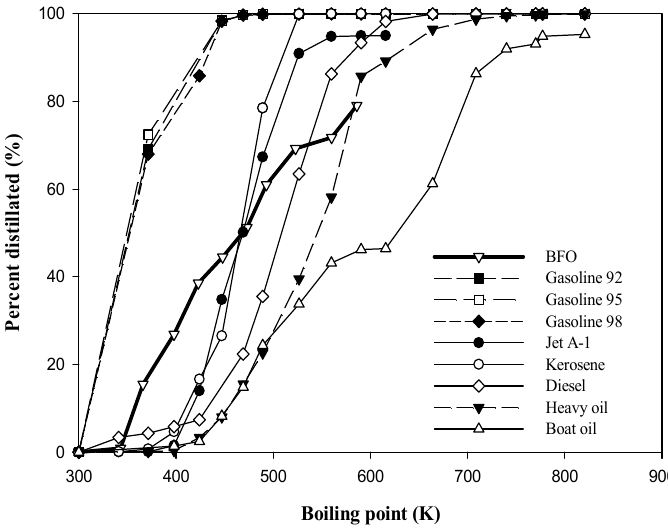
Figure 1. Simulated distillation characteristic of BFO for HTC of JO at T C = 683 K, t r = 60 min and P H2 = 0.69 MPa (100 psig) comparing with those of different fuels. BFO: this study; fuels other than BFO: Chang et al. [26].